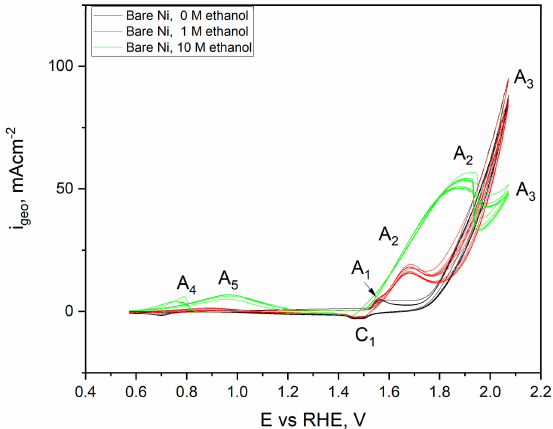
Figure 12. Cyclic voltammetry scans performed for flat Ni electrode in 1 M NaOH electrolyte with and without ethanol addition (1 and 10 M) registered with a sweep rate of 50 mV s − 1 . Ten cycles were performed in one CV